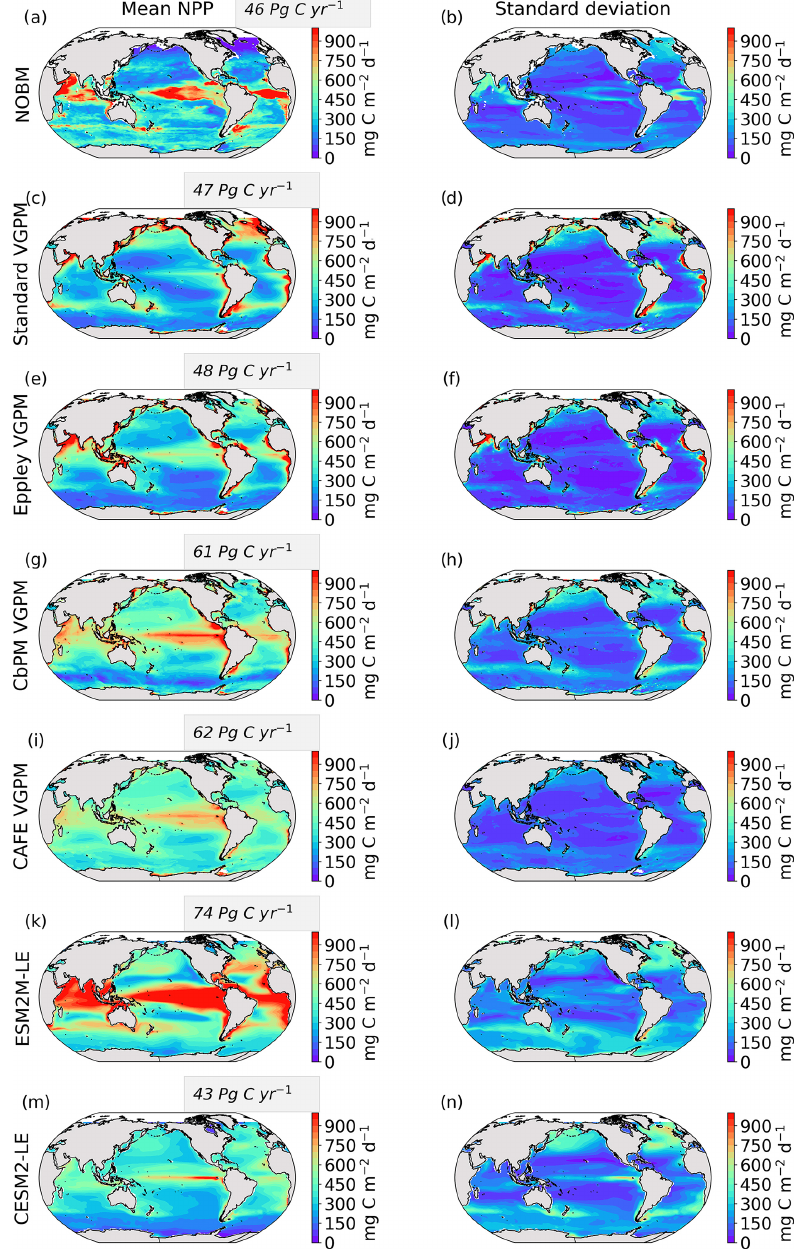
Figure B1. Climatological mean and standard deviation of the observation-based NPP estimates (mgCm − 2 d − 1 ) calculated from NOBM (a, b) , Standard VGPM (c, d) , Eppley-VGPM (e, f) , CbPM (g, h) , and CAFE (i, j) and simulated by ESM2M-LE (k, l) and CESM2- LE (m, n) over 1998–2018. Gray boxes indicate the globally integrated mean NPP (PgCyr − 1 ). We use 5d mean NPP output for all products except for the VGPM-based products (c–j)